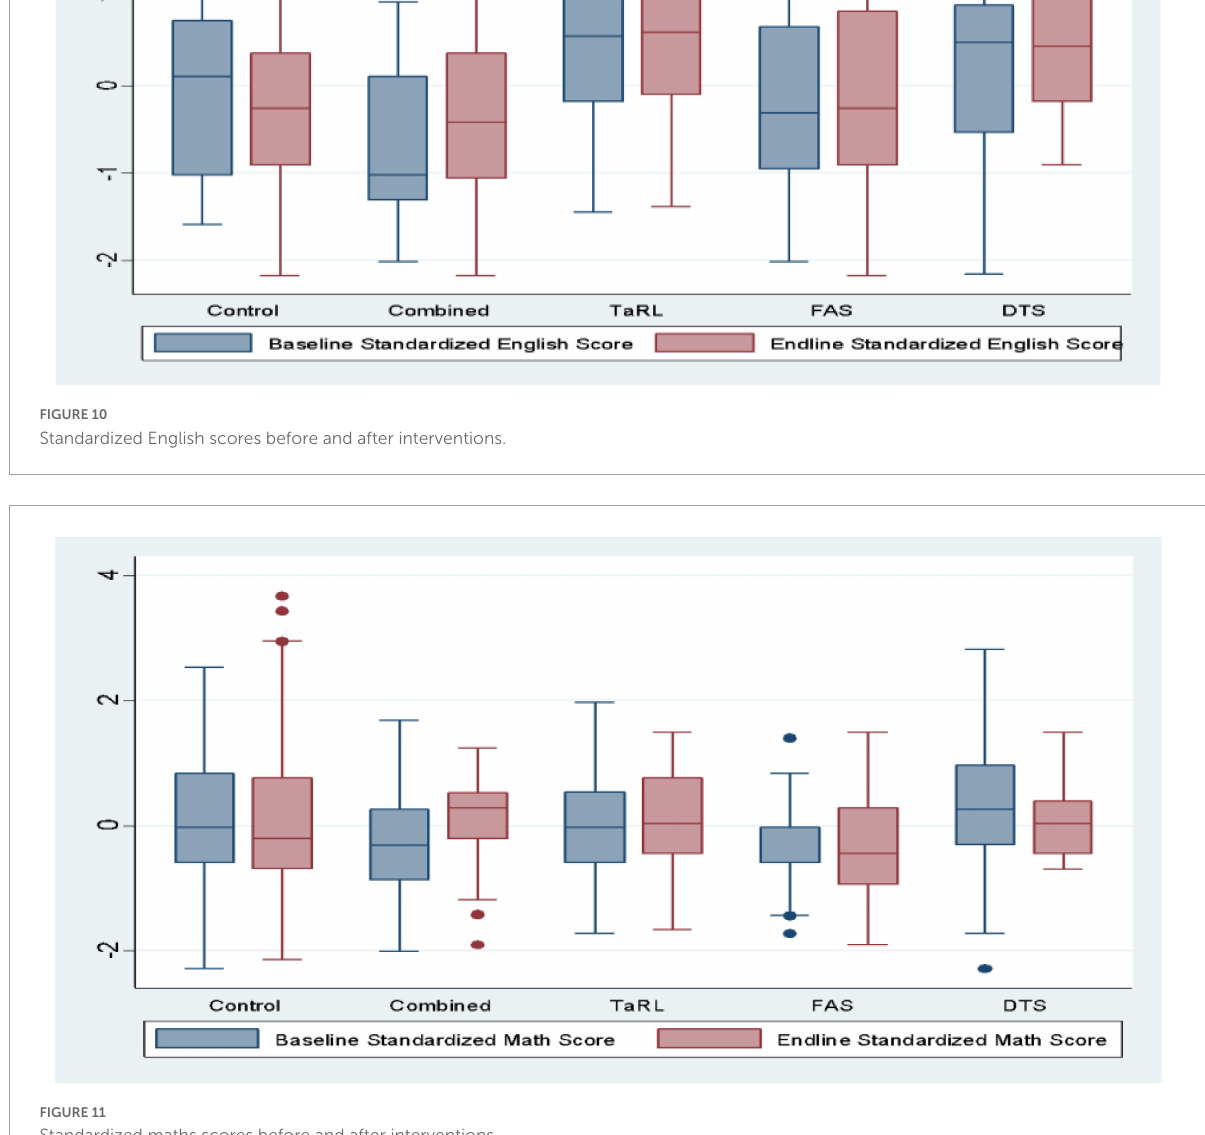
FIGURE11 Standardized maths scores before and after